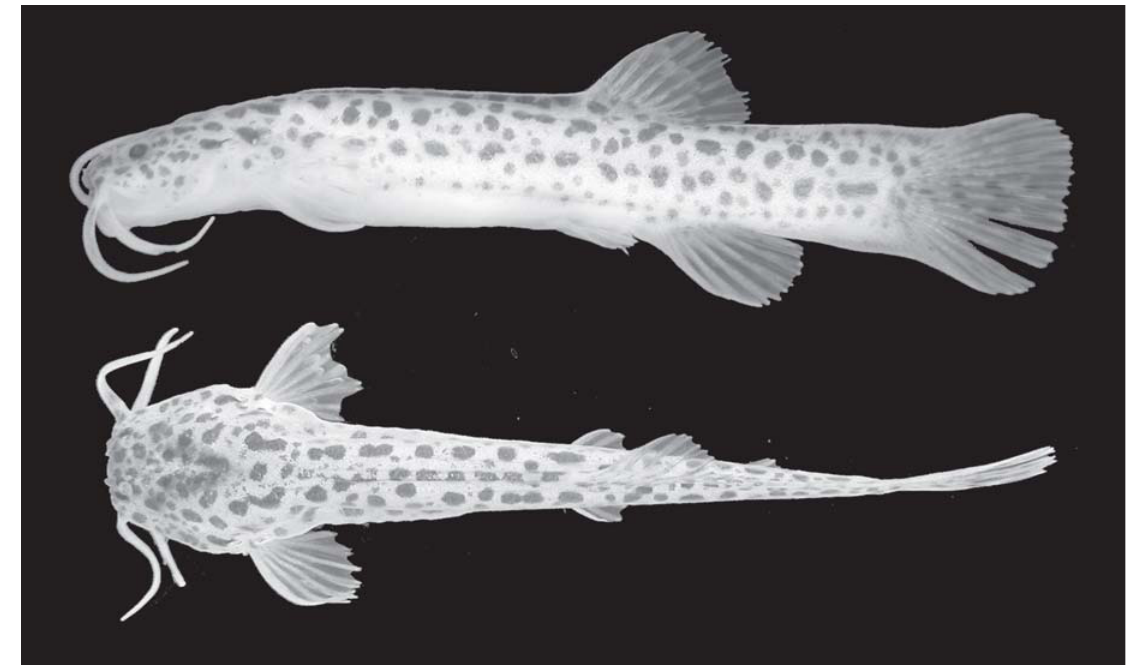
Fig. 2. Trichomycterus maracaya , n. sp. (ZUEC 6138), juvenile 22.8 mm SL, paratype.